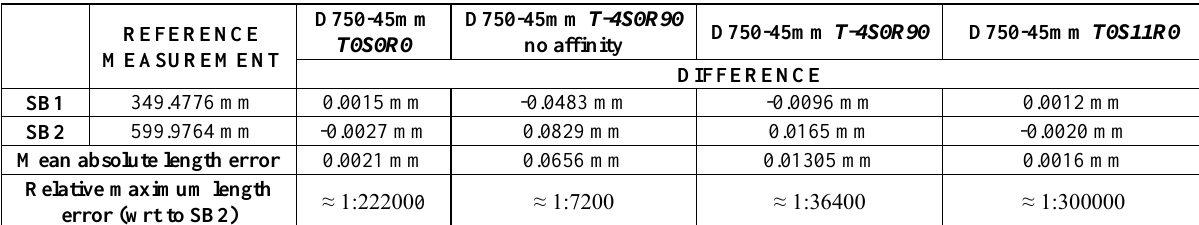
Table 4. External assessment of the self-calibrating bundle adjustment for the photogrammetric systems tested: length error on reference scale